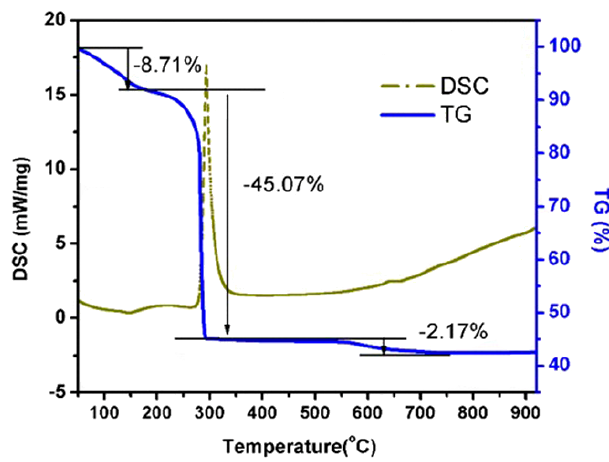
Figure 1. TG–DSC curve of the submicron CCTO precursor.